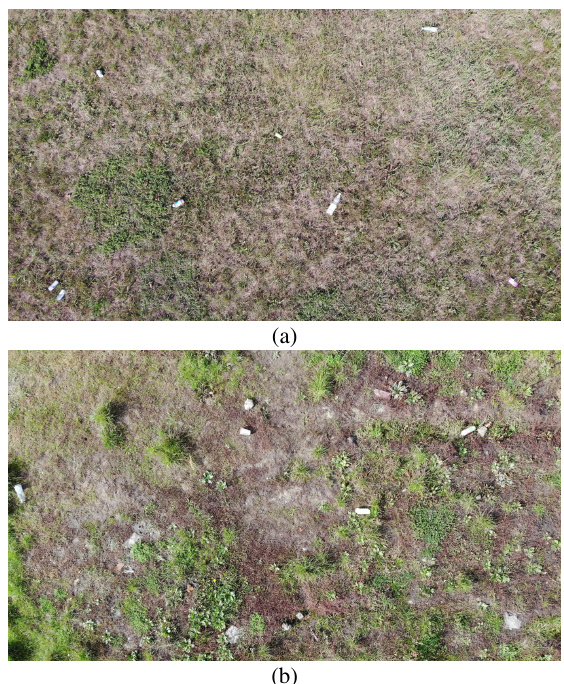
Figure 4. Examples of images taken from the training